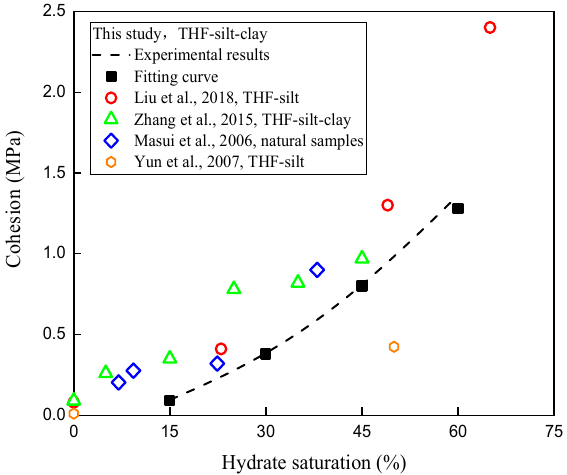
Figure 6. The relationship between the cohesion and hydrate saturation (based on [21–23,26]).